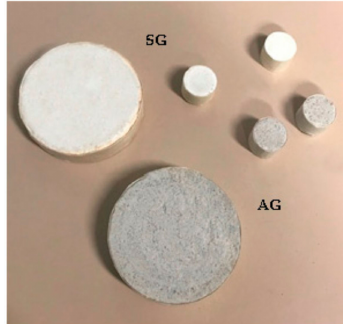
Figure 3. The investigated gypsum of Agadir and Safi cylindrical samples for the large and small